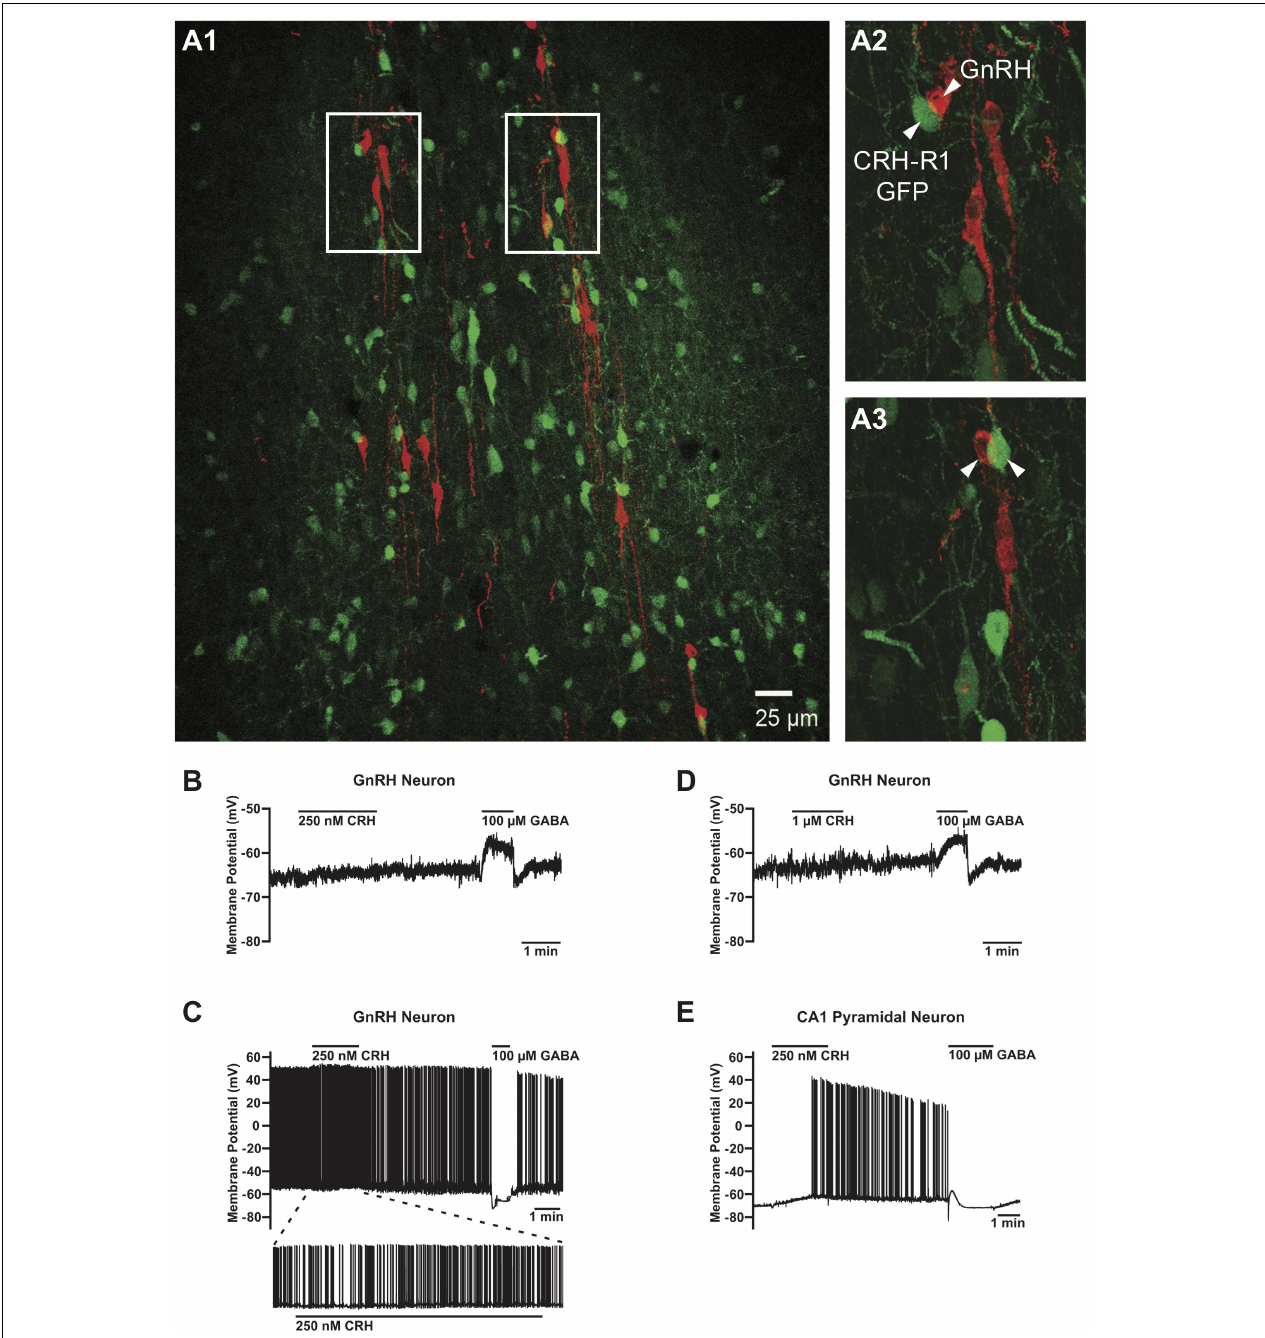
FIGURE 3 | Absence of the CRHR1-GFP signal in GnRH neurons and lack of their electrophysiological responses to CRH. (A) GFP-positive neurons (green) in close proximity of GnRH neurons (red) (A1) . However, no GFP signals were found in any of the GnRH neurons analyzed. Arrowheads point to CRHR1-GFP and GnRH neurons. Scale bars = 100 µ m (A1) and 10 µ m (A2, A3) . (B) Lack of effect of 250 nM CRH on membrane potential in a non-firing GnRH neuron from a postnatal day (P) 44 GnRH-GFP mouse. (C) Lack of effect of 1 µ M CRH on membrane potential in a non-firing GnRH neuron from a P36 GnRH-GFP mouse. (D) Lack of effect of 1 µ M CRH on membrane potential and action potential firing in an active (i.e., spontaneously firing) GnRH neuron from a P38 GnRH-GFP mouse. (E) Depolarization and an increase in action potential firing evoked by 250 nM CRH in a non-firing hippocampal CA1 pyramidal neuron from a P37 GnRH-GFP mouse. GABA was applied after CRH to confirm the responsiveness of the cells to neurotransmitters/neuromodulators and the correct positioning of the drug application flow pipe. GnRH neurons responded to GABA with a depolarization (B, D) or a hyperpolarization (C) , and CA1 pyramidal neurons responded to GABA with a transient hyperpolarization followed by a transient depolarization and a sustained hyperpolarization (E) , in accordance with previous studies (Staley et al., 1995; Herbison and Moenter, 2011).